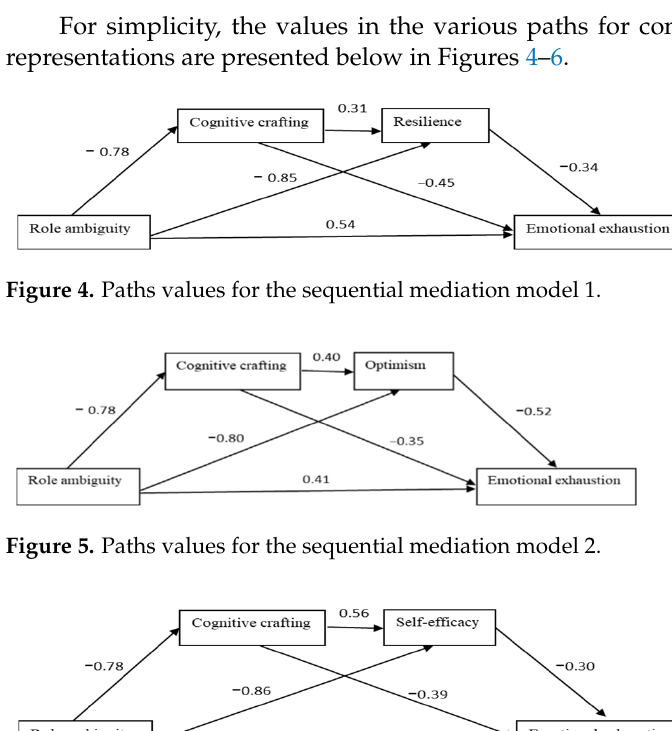
Figure 6. Paths values for the sequential mediation model 3.